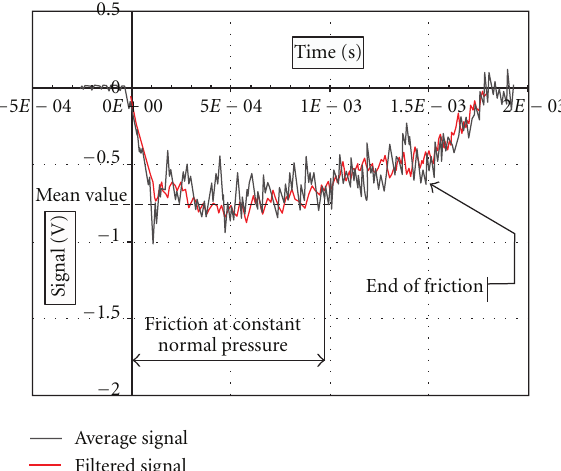
Figure 5: Principal vibration eigenmodes of the sensor at 2169 Hz (flexure mode around the z